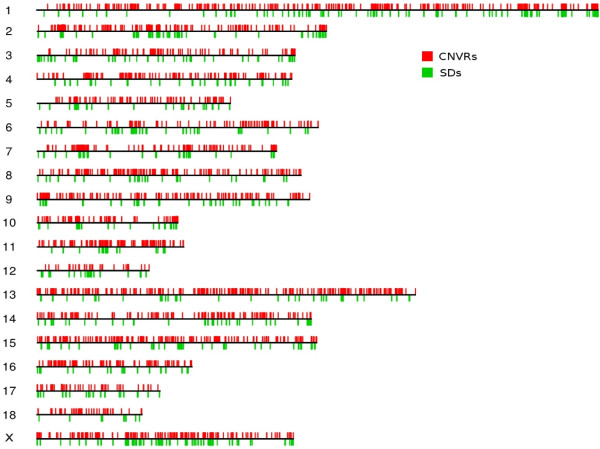
Distribution of CNVRs and SDs across the porcine genome. Black lines represent all 18 autosomes and the sex chromosome X. Red lines on the upper part of chromosomes indicate the 3,118 CNVRs and green lines on the lower part of chromosomes indicate 1,934 SDs.